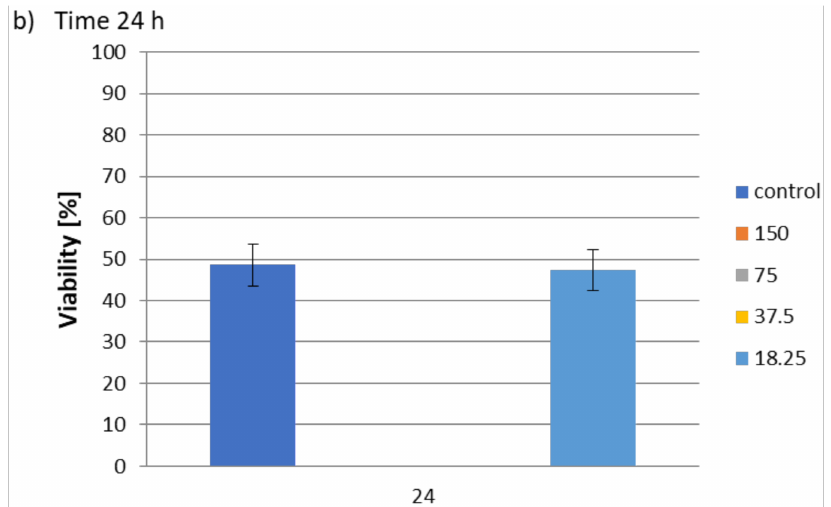
Figure 5. Influence of hydrophilic components (water extract) of C. vulgaris biomass on S. feltiae viability: ( a ) time 0; ( b ) after 24 h of